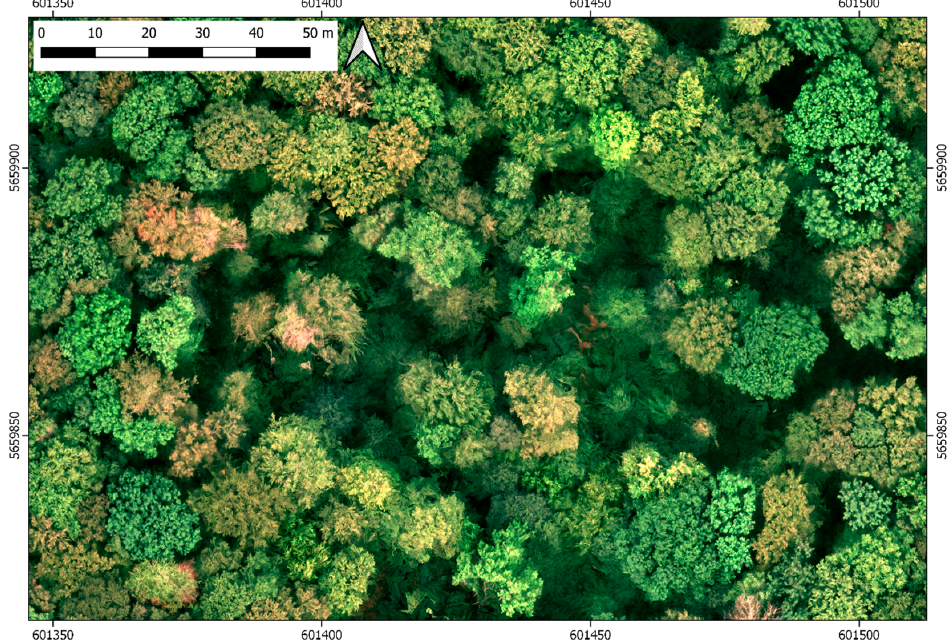
Figure 5. Subset of a UAS imagery-based orthomosaic (acquisition date 2019/09/19) for the Huss site. Due to the summer drought, foliage coloring and defoliation has already started. Still, the leaves prevent the view of the forest floor and dead wood can only be detected in canopy gaps.